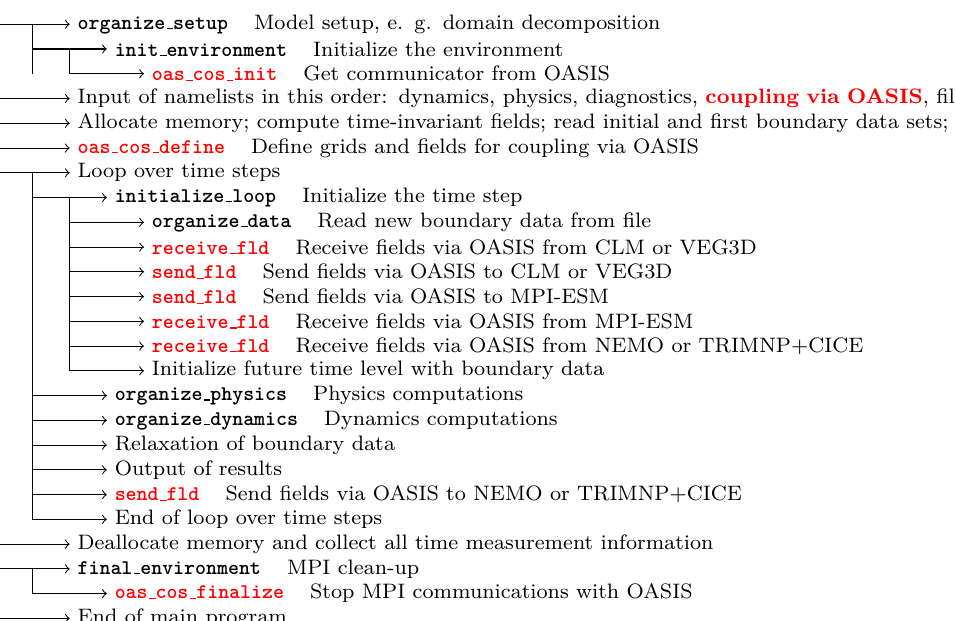
Figure 7. Simplified flow diagram of the main program of the COSMO model in Climate Mode (CCLM), version 4.8_clm19_uoi . The red highlighted parts indicate the locations at which the additional computations necessary for coupling are executed and the calls to the OASIS interface take place. Where applicable, the component models to which the respective calls apply are